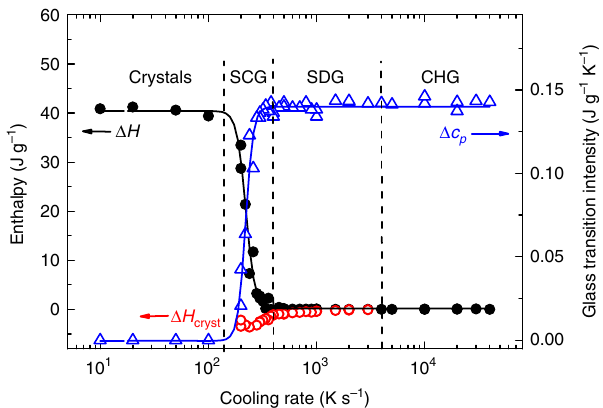
Fig. 5 Indication of different structures. Total enthalpy of the phase transformation ( Δ H ), enthalpy of crystallization during heating ( Δ H cryst ) and intensity of the glass transition ( Δ c p ) upon heating at 6000 K s − 1 (Fig. 4b) vs. cooling rate at which the glass was formed. Four different states can be clearly observed: the fully crystalline region, the semi- crystalline glass (SCG), the self-doped glass (SDG), and the chemically homogeneous glass